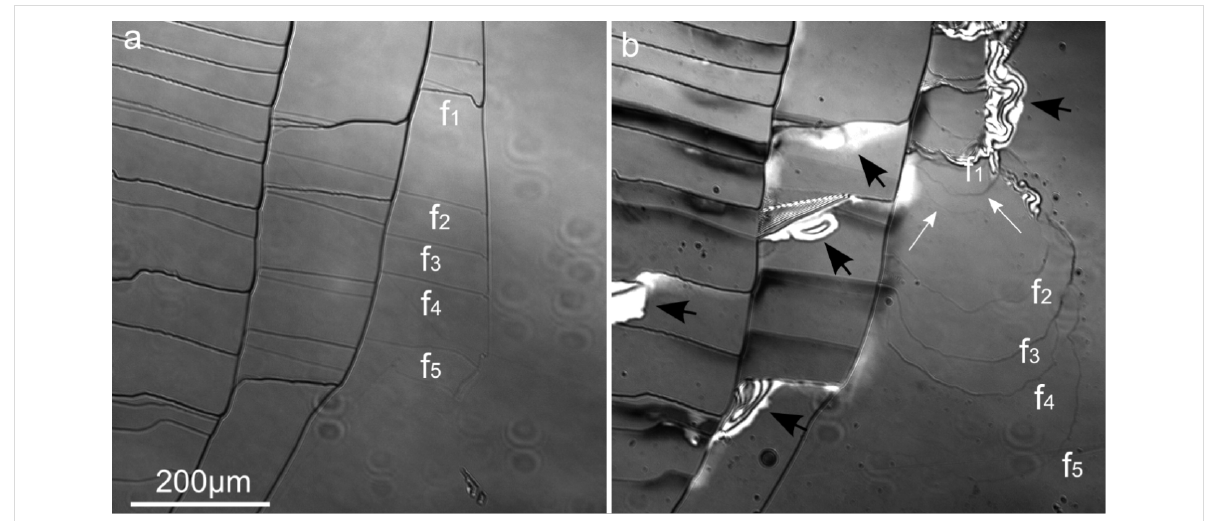
Figure 2: LCM-DIM images: a) freshly cleaved biotite (001) surface and b) the same surface after about 63 h at pH 1 and at 11.5 °C. Black arrows indicate swelling and peeling layers. White arrows indicate new dissolution fronts breaking away from slower moving step edges. Darker areas in b) correspond to higher steps whose upper layers are dissolving. Lower steps (f 1 –f 5 ) move across the surface following a semi-circular pattern and creating unaltered biotite surface. The pale elliptic structures are dust particles derived from the objective lens.